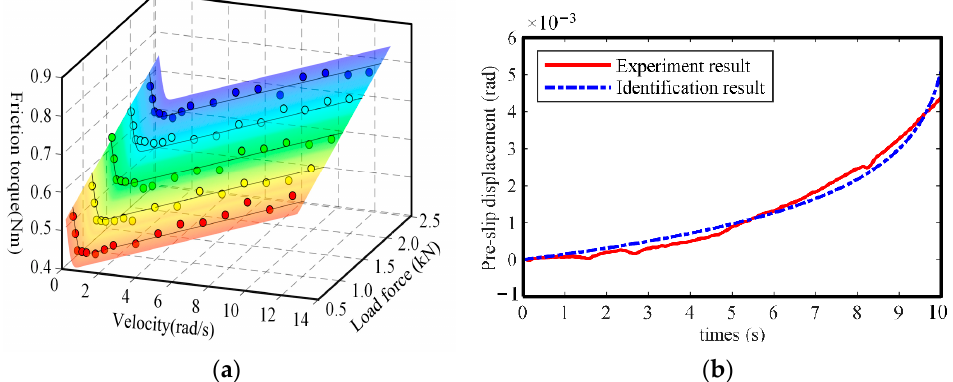
Figure 2. Identification results of friction parameters. ( a ) Experimental and identification results of friction with static parameters. ( b ) Experimental and identification results of pre-slip displacement with dynamic parameters.